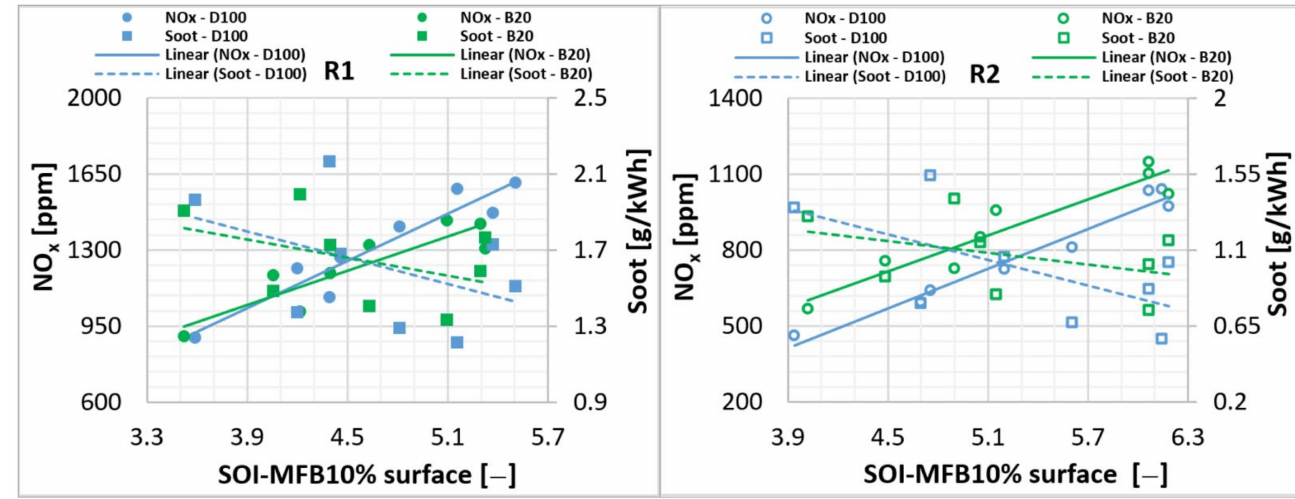
Figure 15. NO x and Soot trendlines variation relative to SOI–MFB10% surface